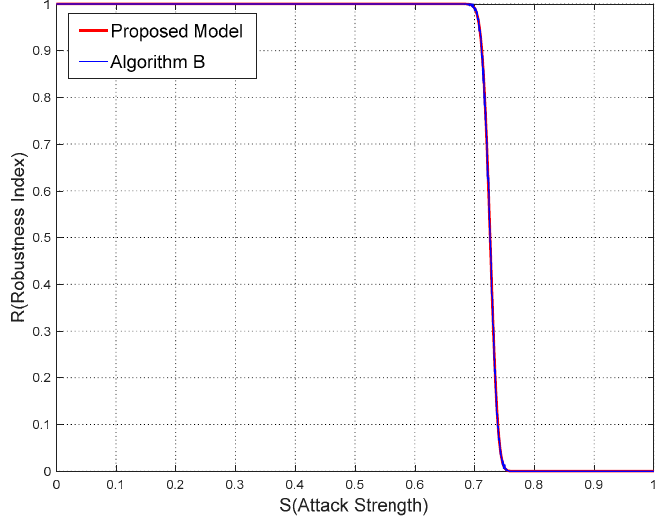
Figure 12. Comparisons of results from the proposed model and Algorithm B in Experiment 2.